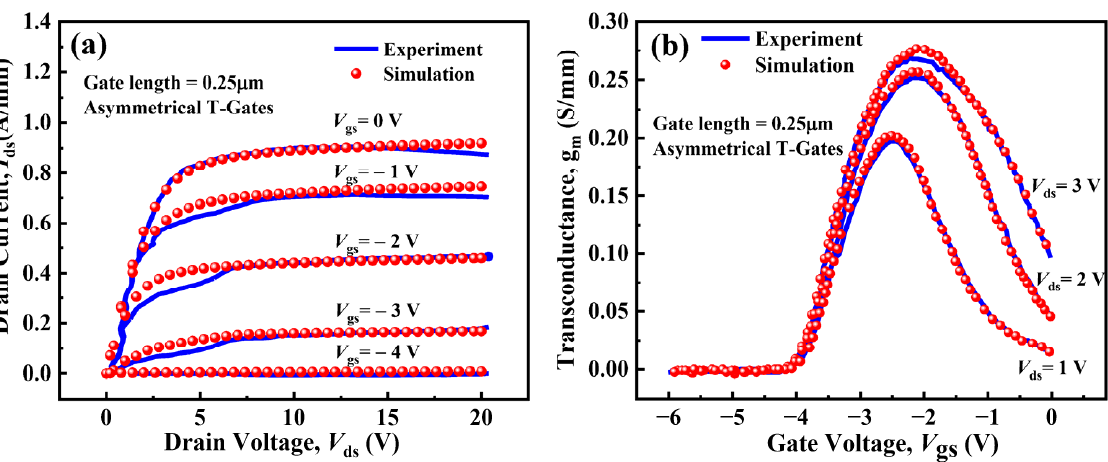
Figure 5. ( a ) Output characteristics of the asymmetrical T ‐ gate AlGaN/GaN HEMT on a silicon carbide substrate with a gate length of 0.25 μ m before stress and ( b ) transfer characteristics before stress [14].